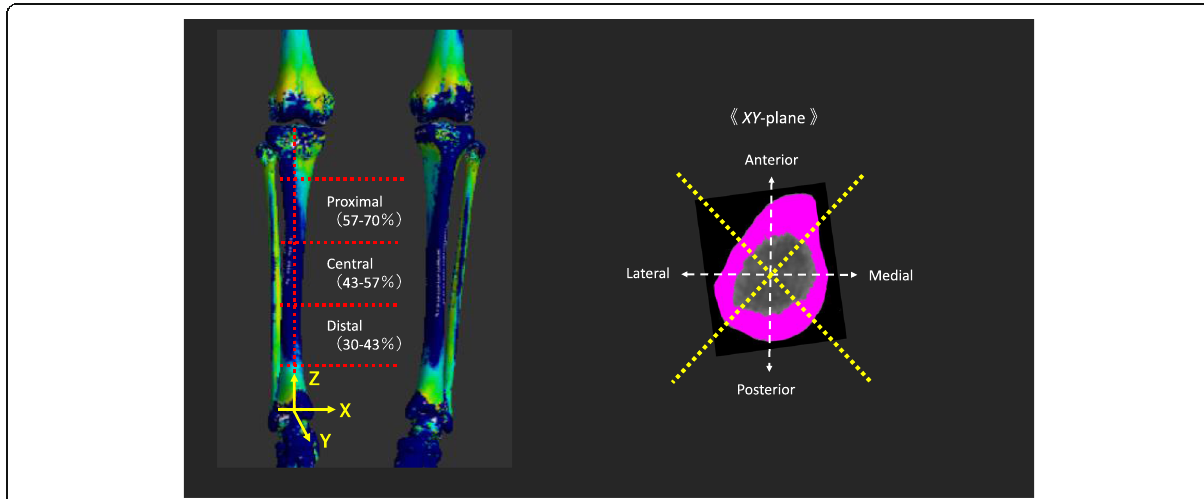
Fig. 4 Schematic illustration of the tibial coordinate system and 12 regions divided by each of the three heights (proximal, central, and distal) and four areas (medial, anterior, lateral, and posterior). An anatomical coordinate system of the tibia was constructed. Twelve regions were created by combining three heights (proximal, 57% – 70%; central, 43% – 57%; distal, 30% – 43%) and four areas of the axial plane ( xy -plane) at 90° (medial, anterior, lateral, and posterior), comprising cortical thickness data from 200 to 1000 points in each